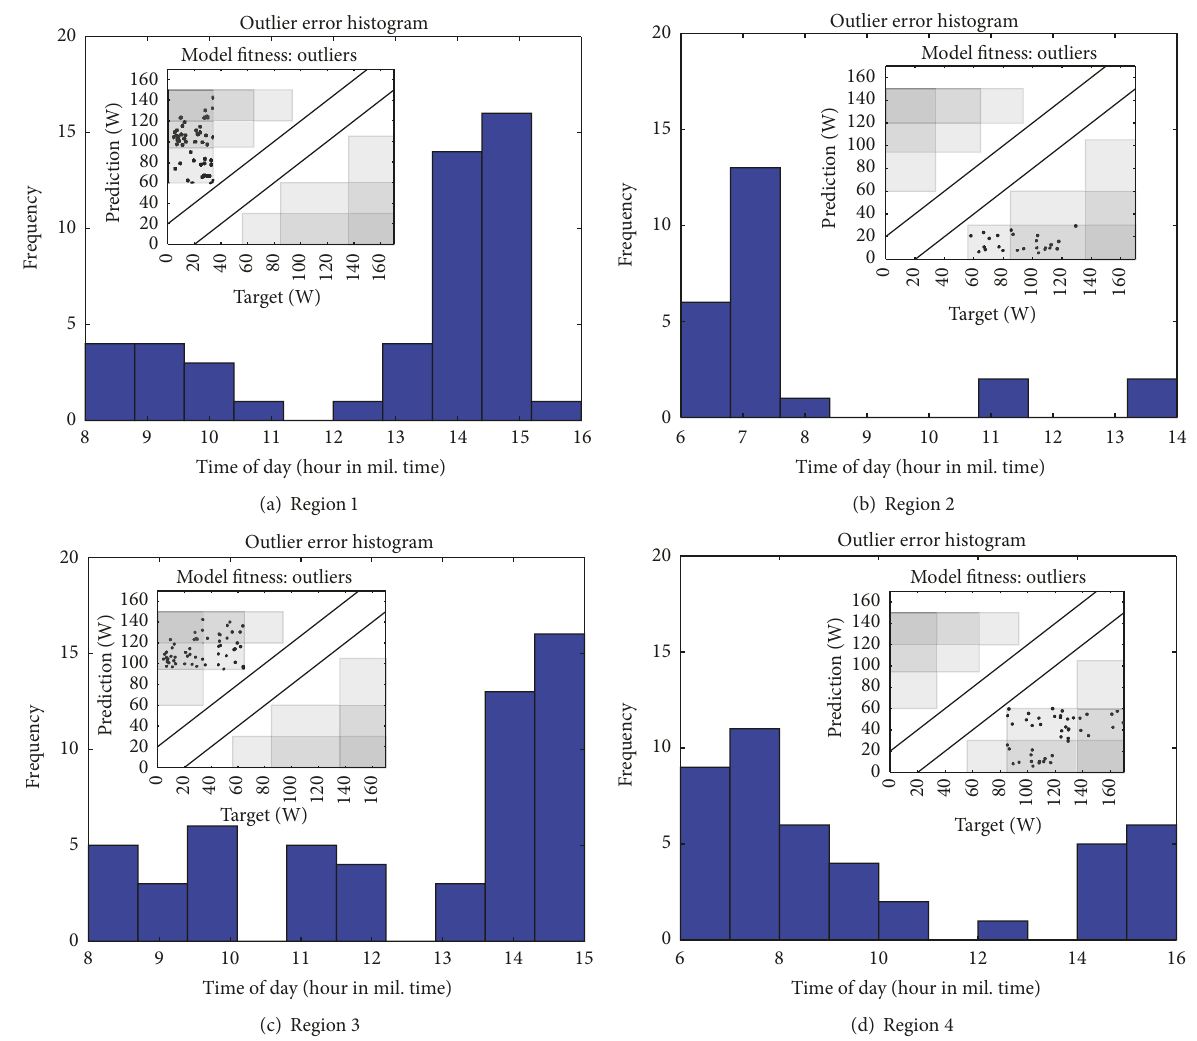
Figure 4: Outliers are filtered by region on the model fitness graph. The model fitness graph is reproduced in the inlay of each chart, with the points within the region indicating the area of the graph the region contains. The histograms show the frequency of each outlier in that region grouped by hour of